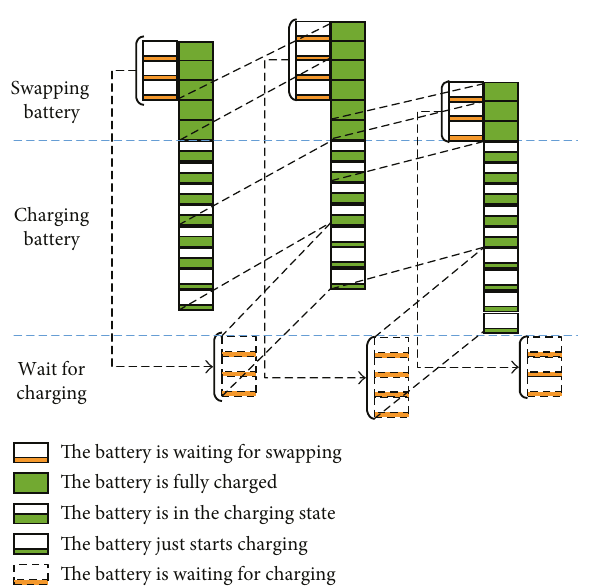
Figure 2: The battery swapping service